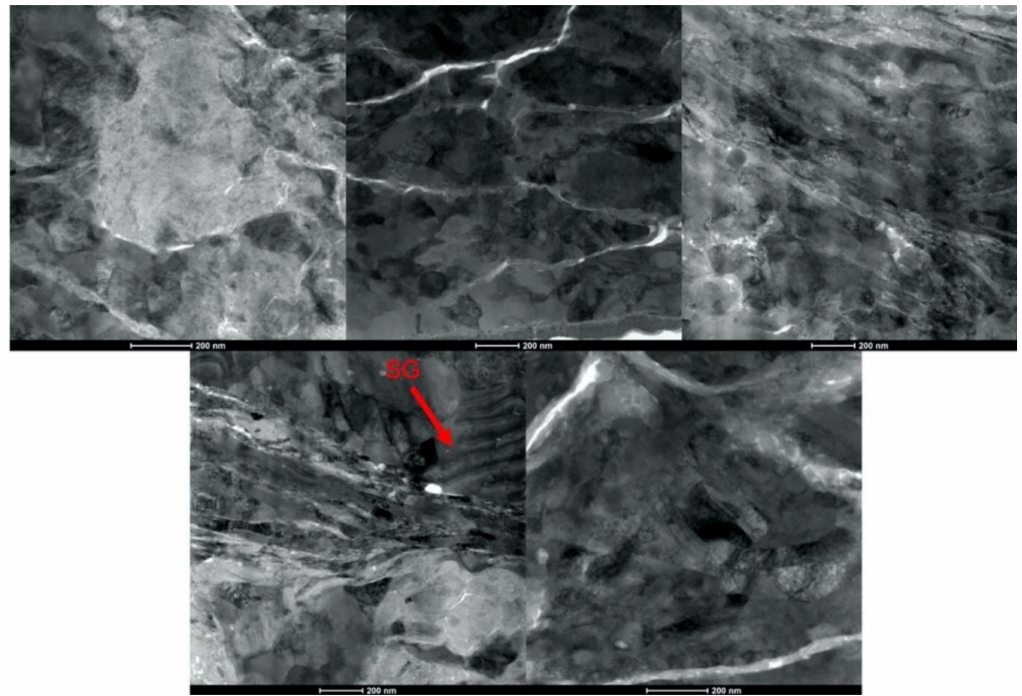
Figure 20. STEM micrographs of the deformed microstructure of the nanostructured cold sprayed coatings in the cross-sectional orientation. Note that the scale bar represents 200 nm. Sub-grain (SG) formation structure is similar to prior reports [83]. This is likely attributable to the UFG Cu